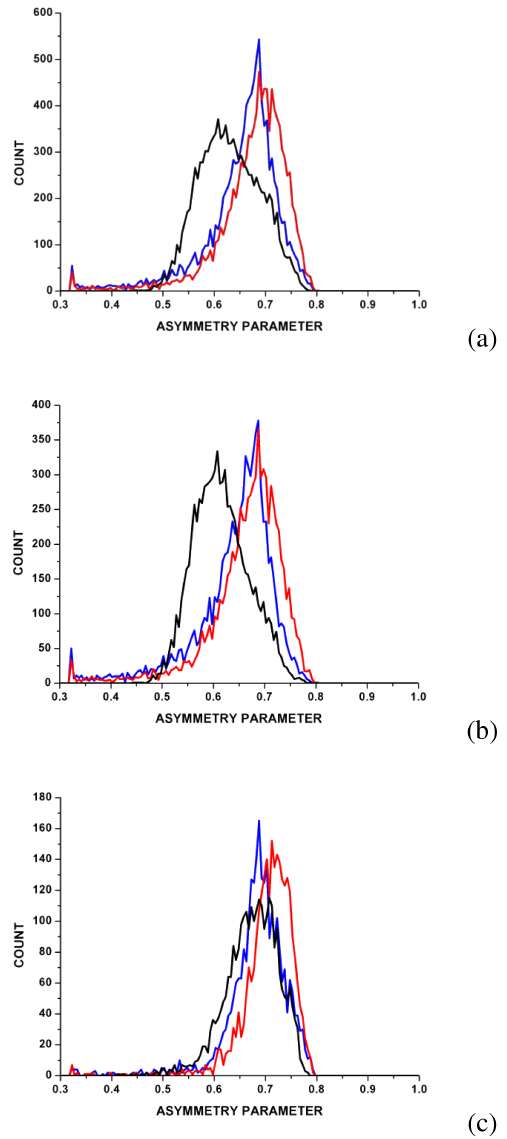
Figure 10. Frequency distribution histograms for MODIS- Terra (red colored lines) MODIS-Aqua (blue-colored lines) and AERONET (black lines) g aer values at 860 and 870nm, respec- tively. The histograms are given separately for (a) the entire study region, (b) Europe, and (c) Africa, the Middle East and the Arabian